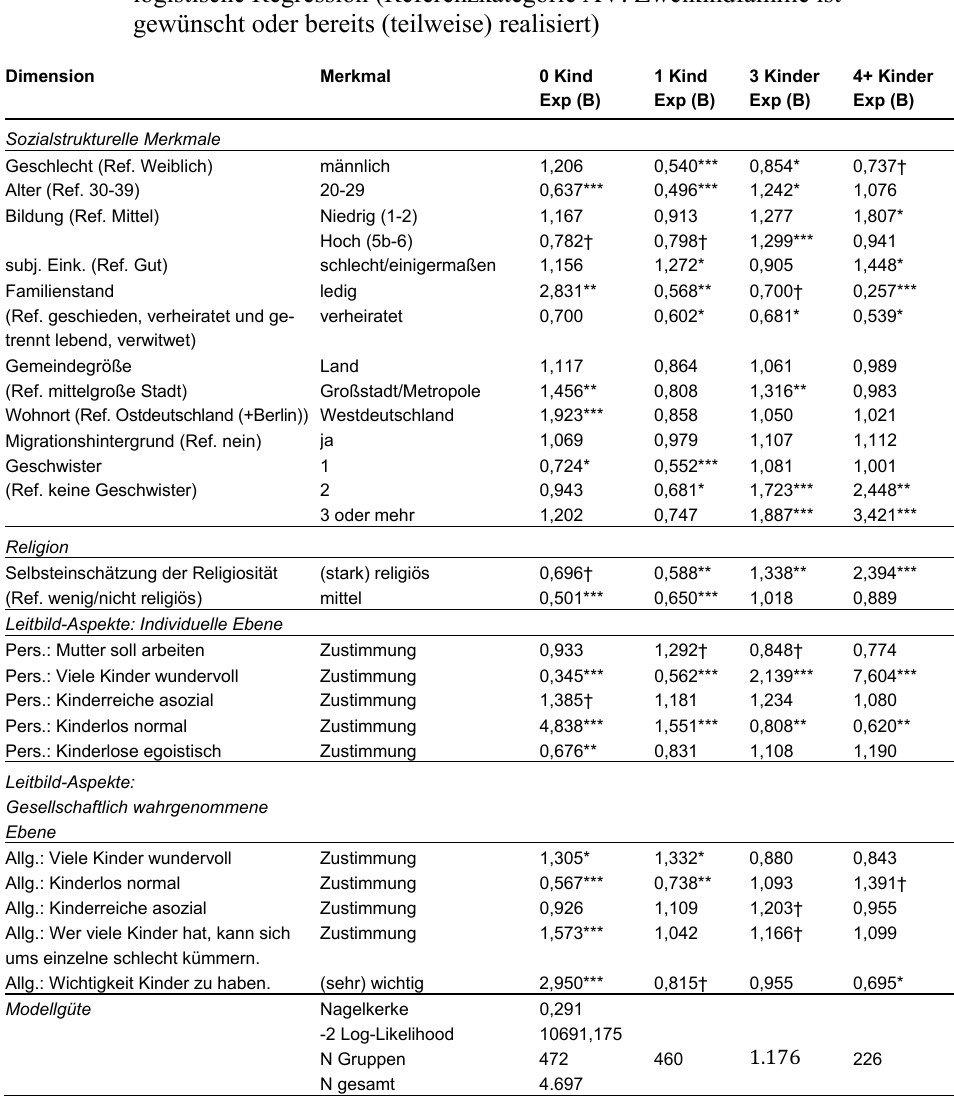
Tabelle 3 : Gesamtmodell zur Abweichung von der Zweikindfamilie -